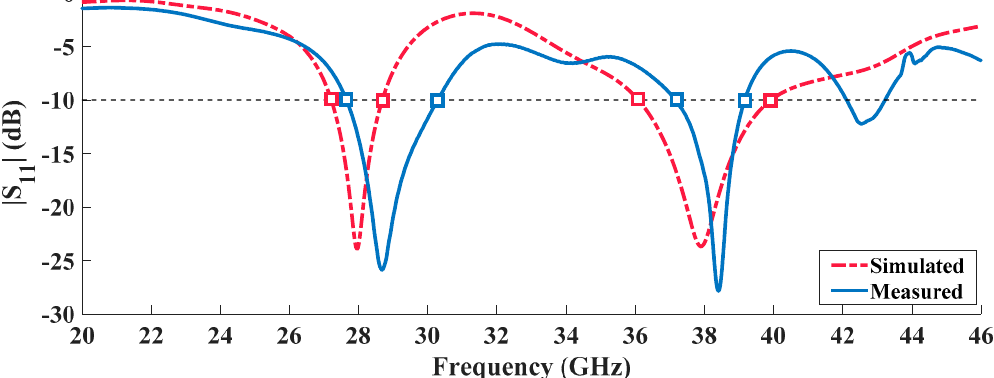
Figure 7. Simulated and Measured Reflection Coefficient of the Dual-Band Antenna.